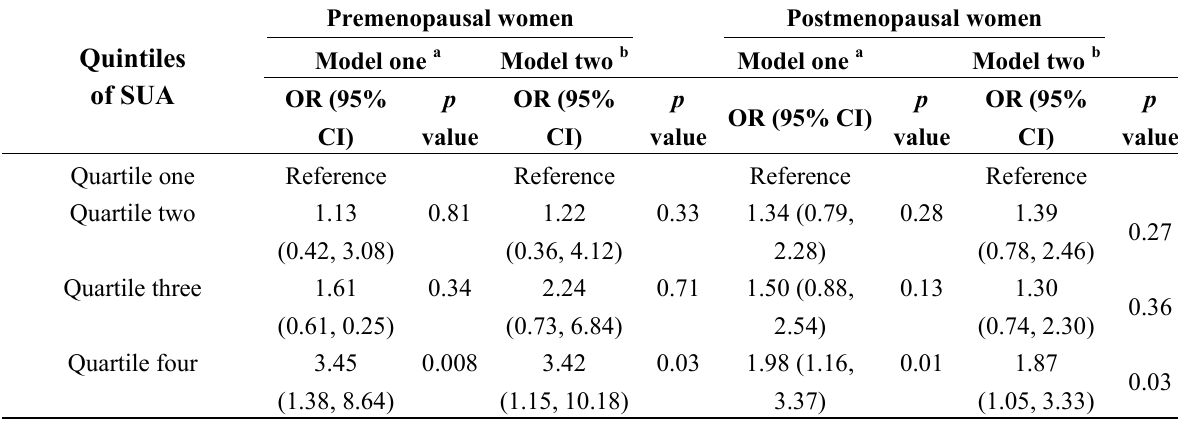
Table 5. Association of uric acid and metabolic syndrome in premenopausal and postmenopausal